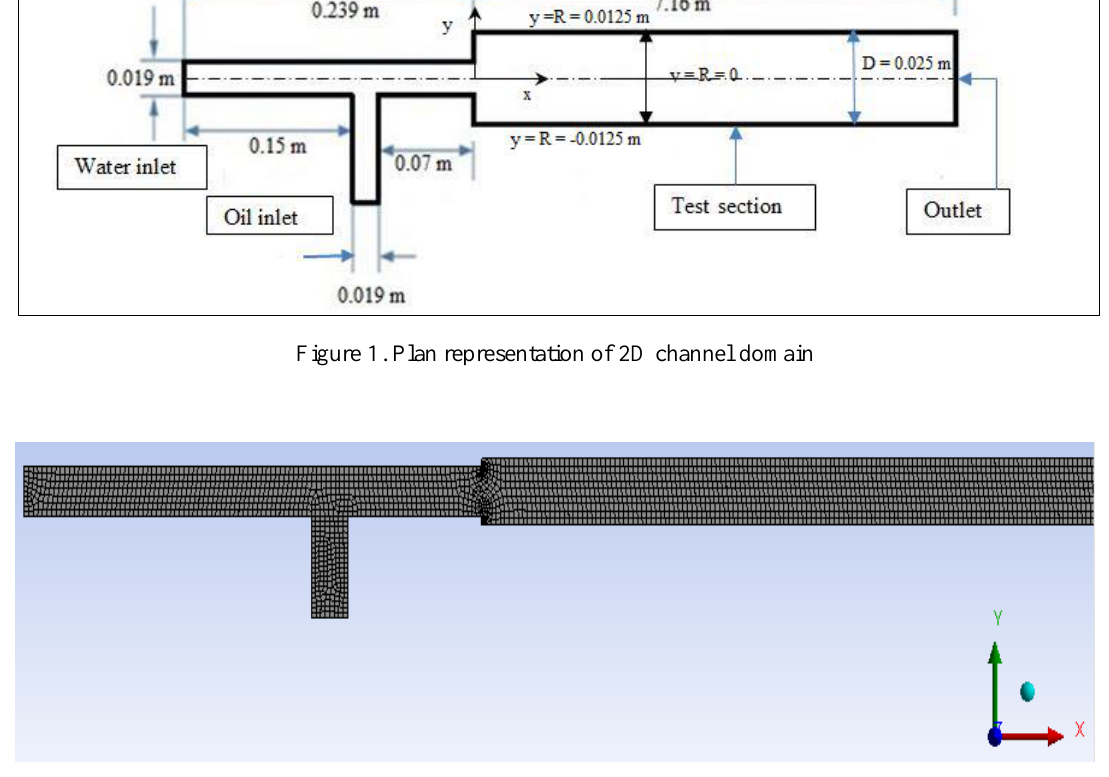
Figure 2. Mesh arrangement of 2D channel